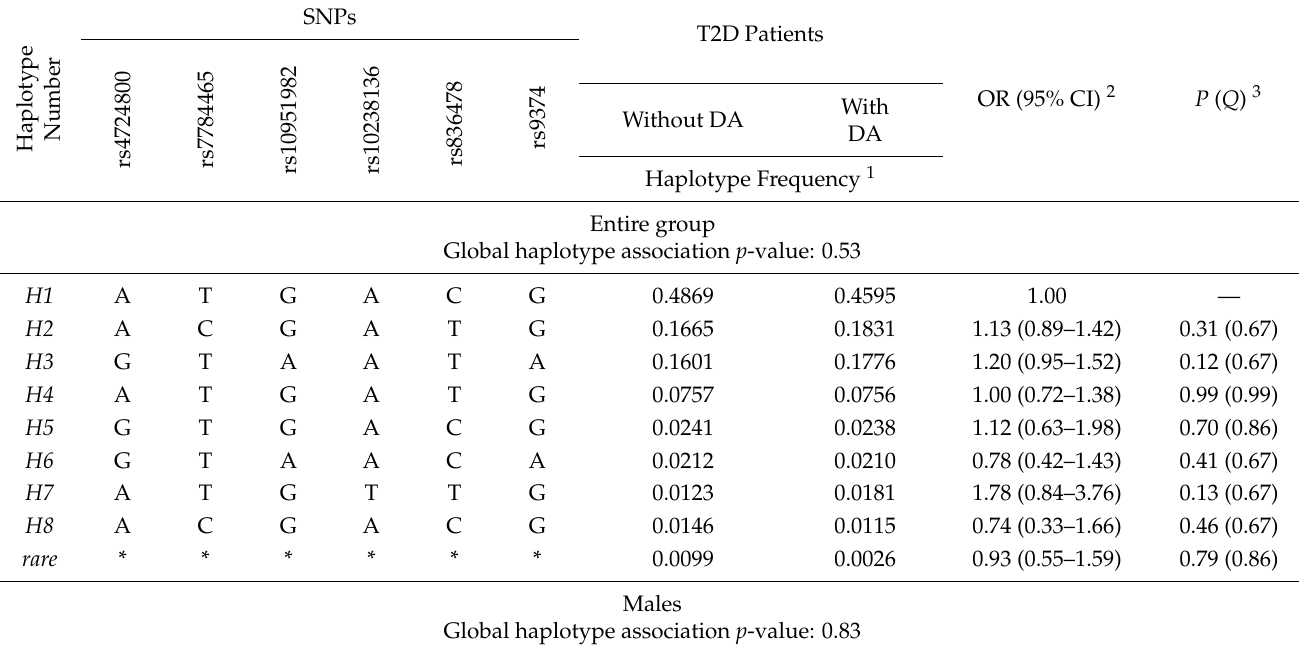
Table 8. Estimated common haplotype frequencies of RAC1 gene in T2D patients with and without diabetic angiopathy of lower